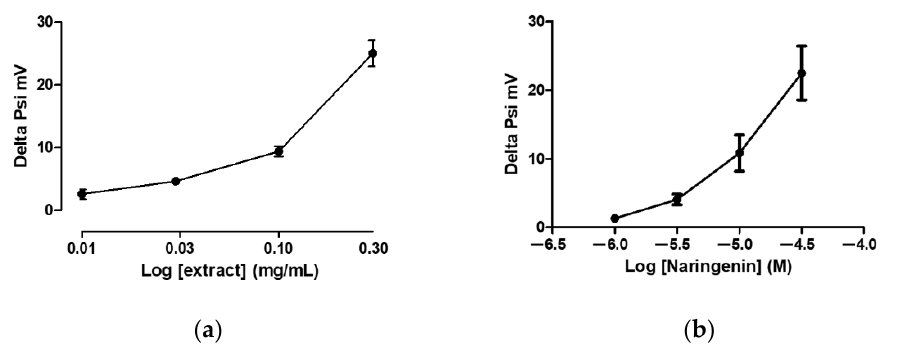
Figure 3. Changes in Delta Psi value (mV) following the addition, into the mitochondrial suspension buffer, of cumulatively increasing concentrations of: ( a ) grapefruit IntegroPectin; ( b ) naringenin. The vertical bars symbolize the standard errors ( n = 6).